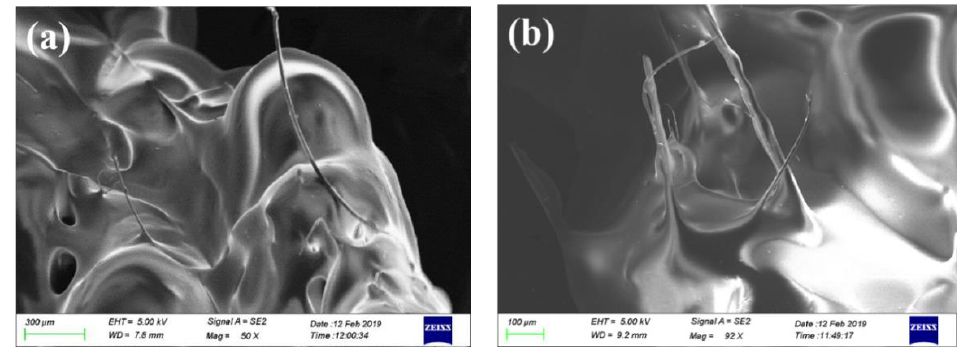
Figure 9. SEM result of aramid fiber-modified asphalt ( a ) magnification: 50×, ( b ) magnification: 92× .